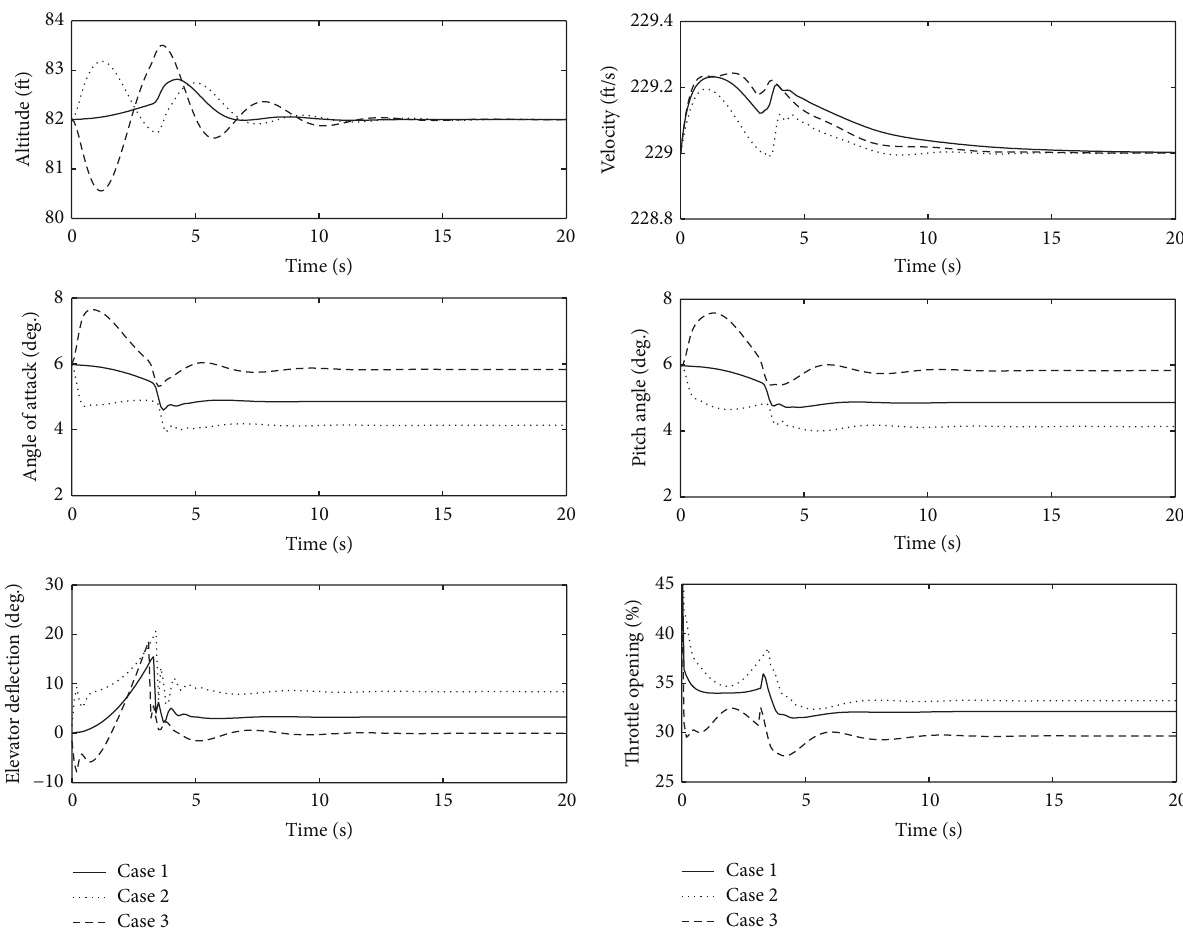
Figure 2: Aircraft responses of the dropping process in the presence of constant disturbances and uncertainties (Cases 1, 2, and 3).